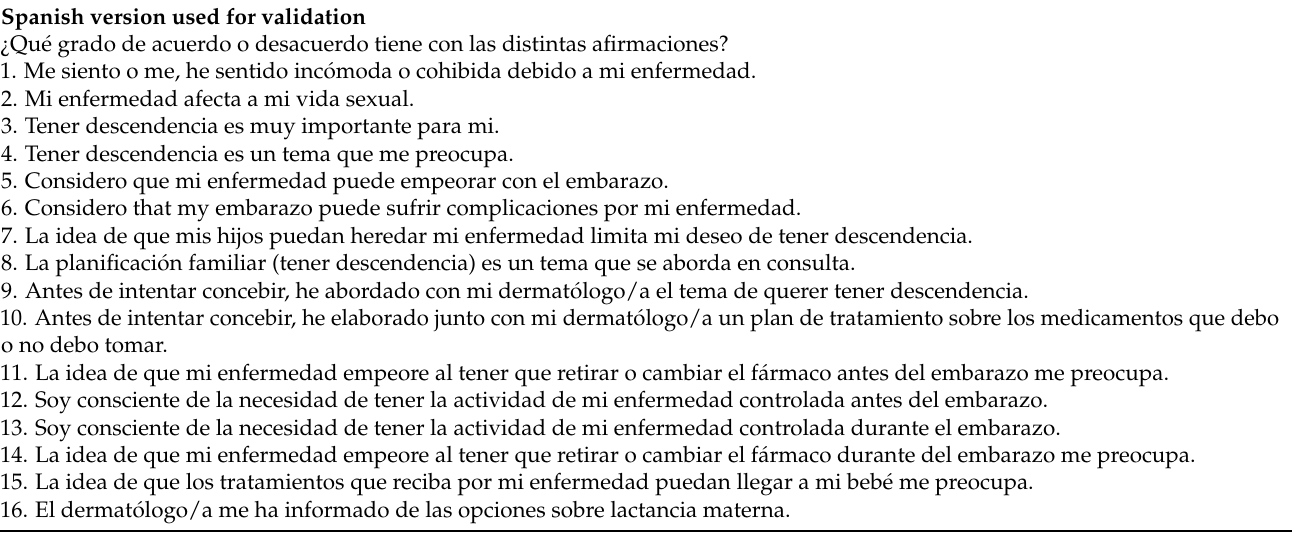
Table 2. Final version of the